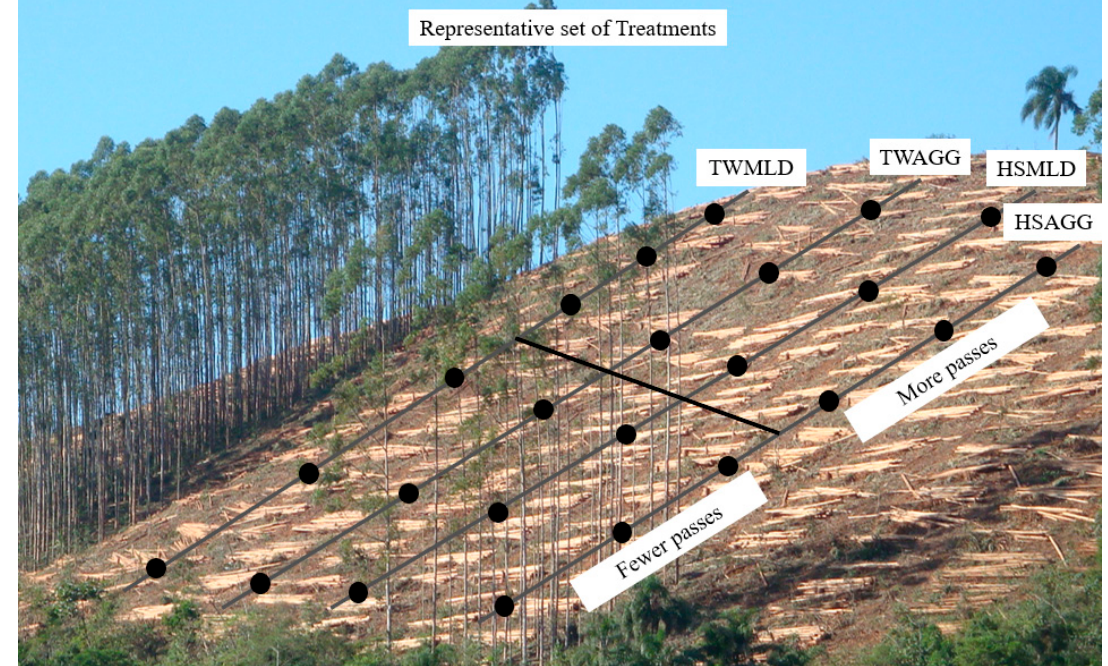
Figure 5. Representative harvest area with one set of 4 treatments (trails). The split mid-slope depicts the lower section of the trails being traversed less than the upper section. Data collection points were spaced equally along the trails: 3 points on the upper section and 3 points on the lower section. There were 3 such areas each for blocks 1 and 2. Block 3 only had 2 treatments in three harvest areas: